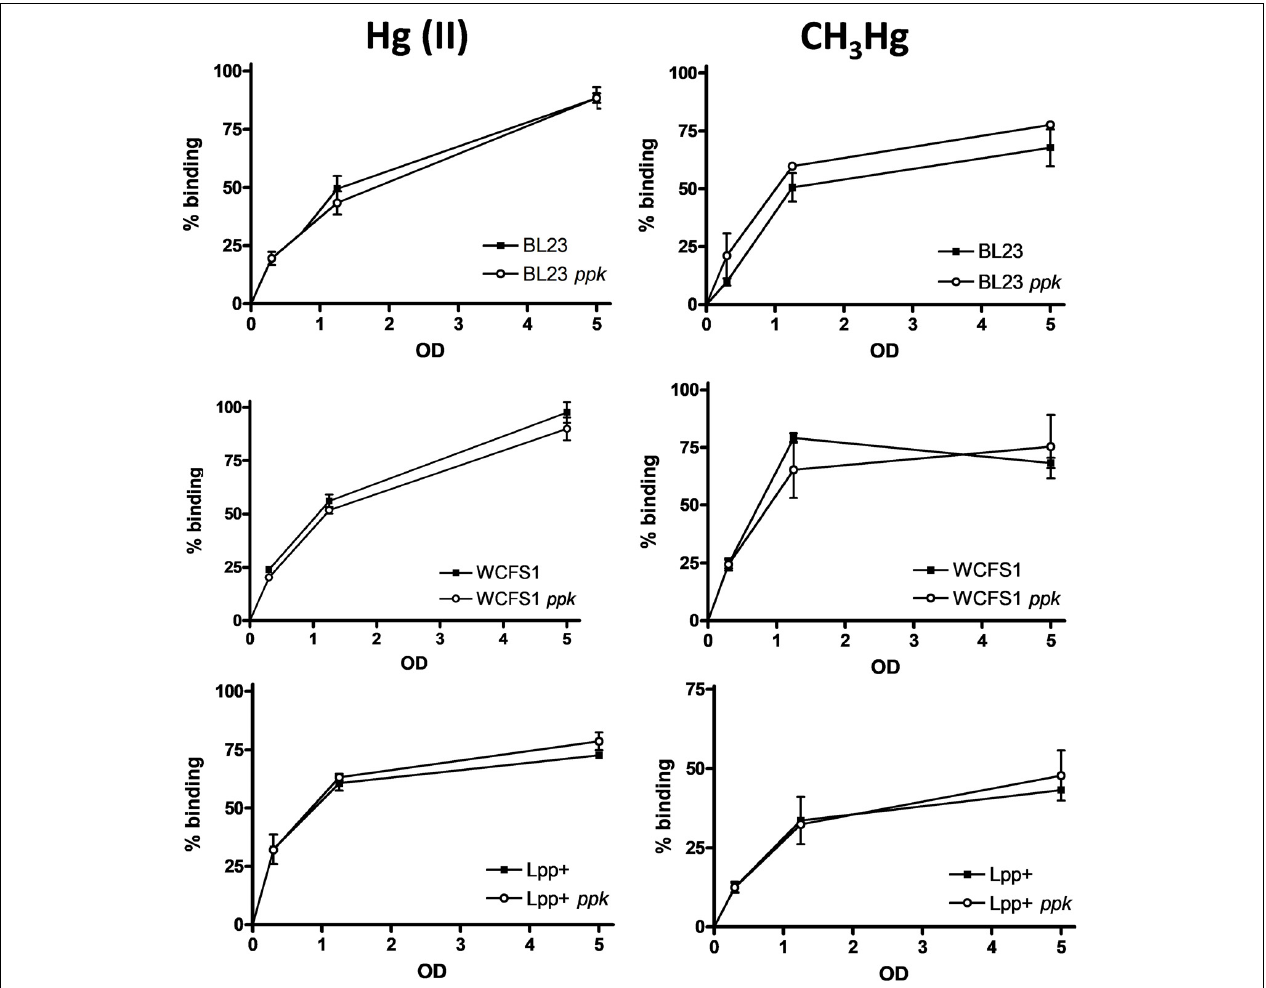
FIGURE 3 | Accumulation of mercury in Lactobacillus strains. Lactobacilli were incubated at different optical densities (OD) with different forms of mercury (inorganic, left column and organic, right column) at 1 mg/l and the amount of the metal bound to bacterial cells was quantified. The data represent the percentages of bound metal plus standard deviations from two independent